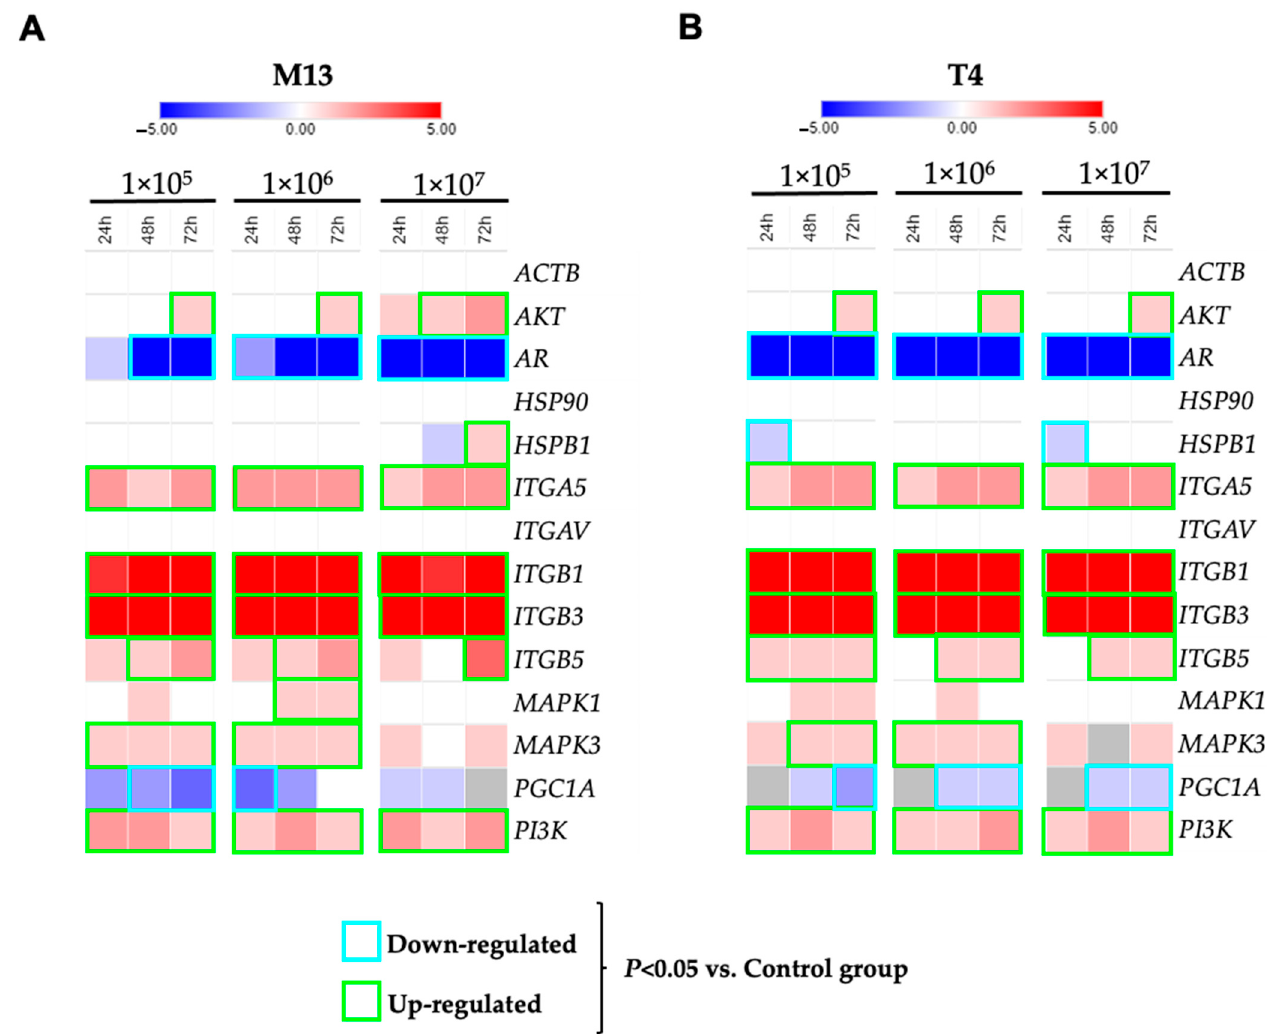
Figure 3. Gene expression of prostate cell line LNCaP after 24, 48, and 72 h of treatment with bacteriophages M13 and T4. Heatmap with a representation of effect on LNCaP cells gene expression after interaction with bacteriophage M13 ( A ) and bacteriophage T4 ( B ). Relative levels of gene expression (median) are shown as a Log 2 Fold-Change. Values between − 5 and 0 represent negatively regulated genes (blue gradient) and, between 0 and 5, represent genes with positive regulation (red gradient). The data surrounded green represents the up-regulated gene with p < 0.05. The data in blue represents the down-regulated gene with p < 0.05.